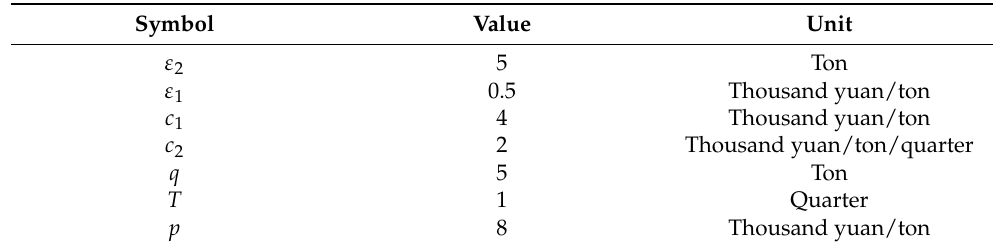
Table 4. The parametric values of the sequential optimization decision model when the prediction values of refined oil demand are used.